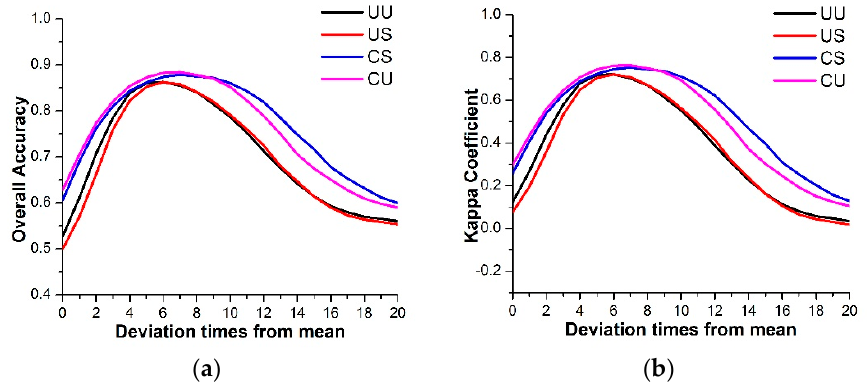
Figure 12. Accuracy assessment curves of MSP under different data quality, where UU denotes data with no atmosphere correction and no application of the Savitzky–Golay filter, while US denotes data with no atmosphere correction and with the Savitzky–Golay filter. CS denotes data with atmosphere correction and with the Savitzky–Golay filter, and CU denotes data with atmosphere correction and no Savitzky–Golay filter applied. ( a ) Overall accuracy; ( b ) kappa coefficient. Both ( a ) and ( b ) are deviation times from the mean of the change magnitudes ( x -axis) with units of 0.25 multiplied by the standard deviation.